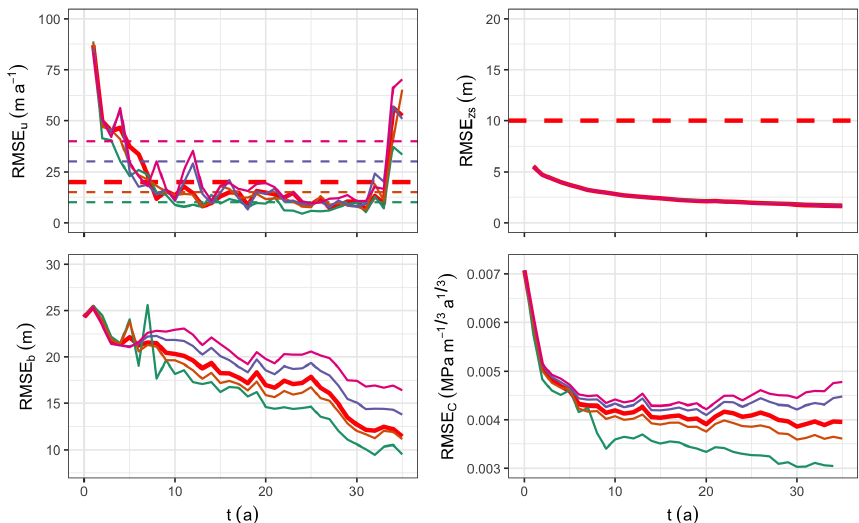
Figure 10. Sensitivity to the surface velocity observation error σ obs u : RMSEs after each analysis, computed only for x ≥ 300km for b and C . The thick red lines correspond to the results with σ obs u = 20ma − 1 and σ correspond to the observation errors σ obs u and the results are presented with solid lines using the same colour code. σ z obs experiments.